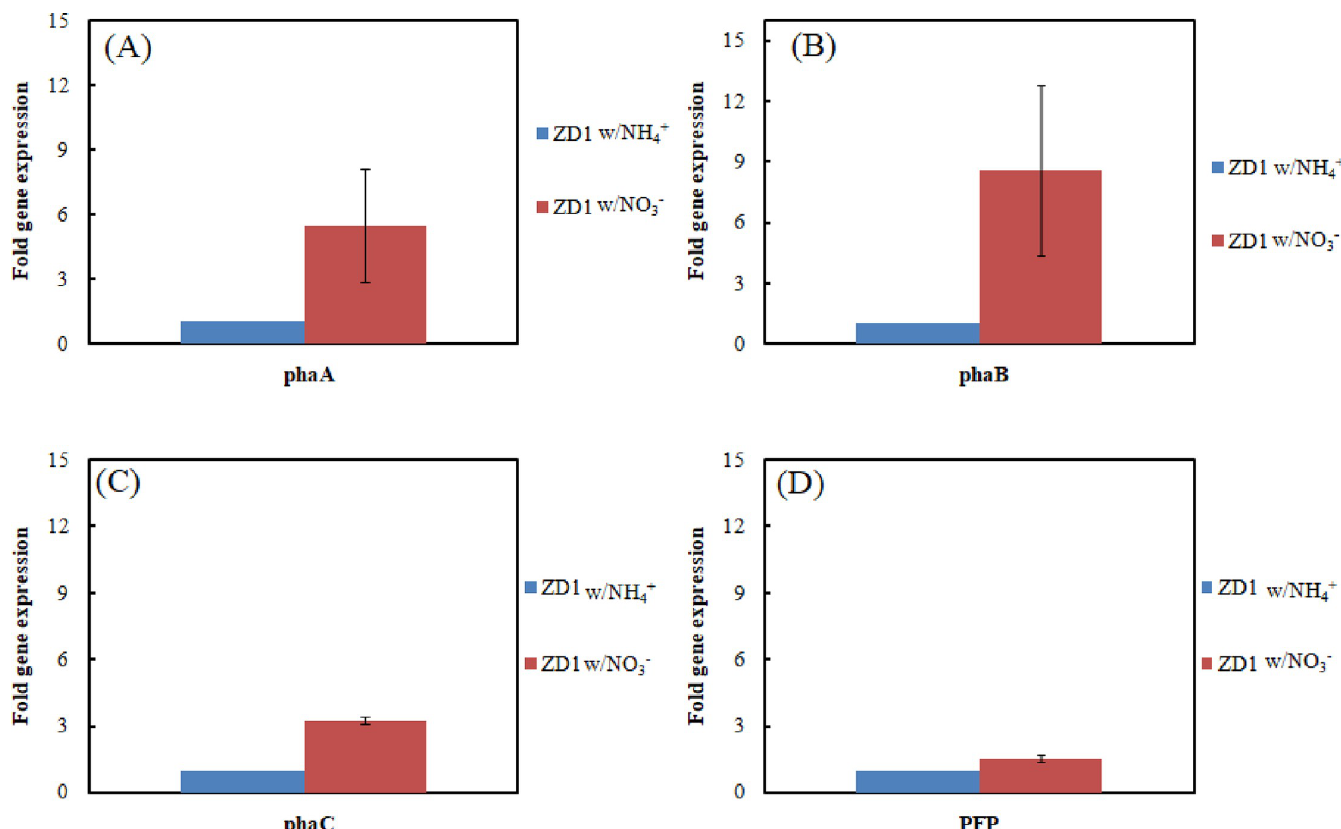
Fig 3. Effects of ammonium (NH 4+ ) and nitrate (NO 3- ) on the expression of PHB synthesis genes. (A) phaA (B) phaB (C) phaC and (D) PFP in Zobellella denitrificans